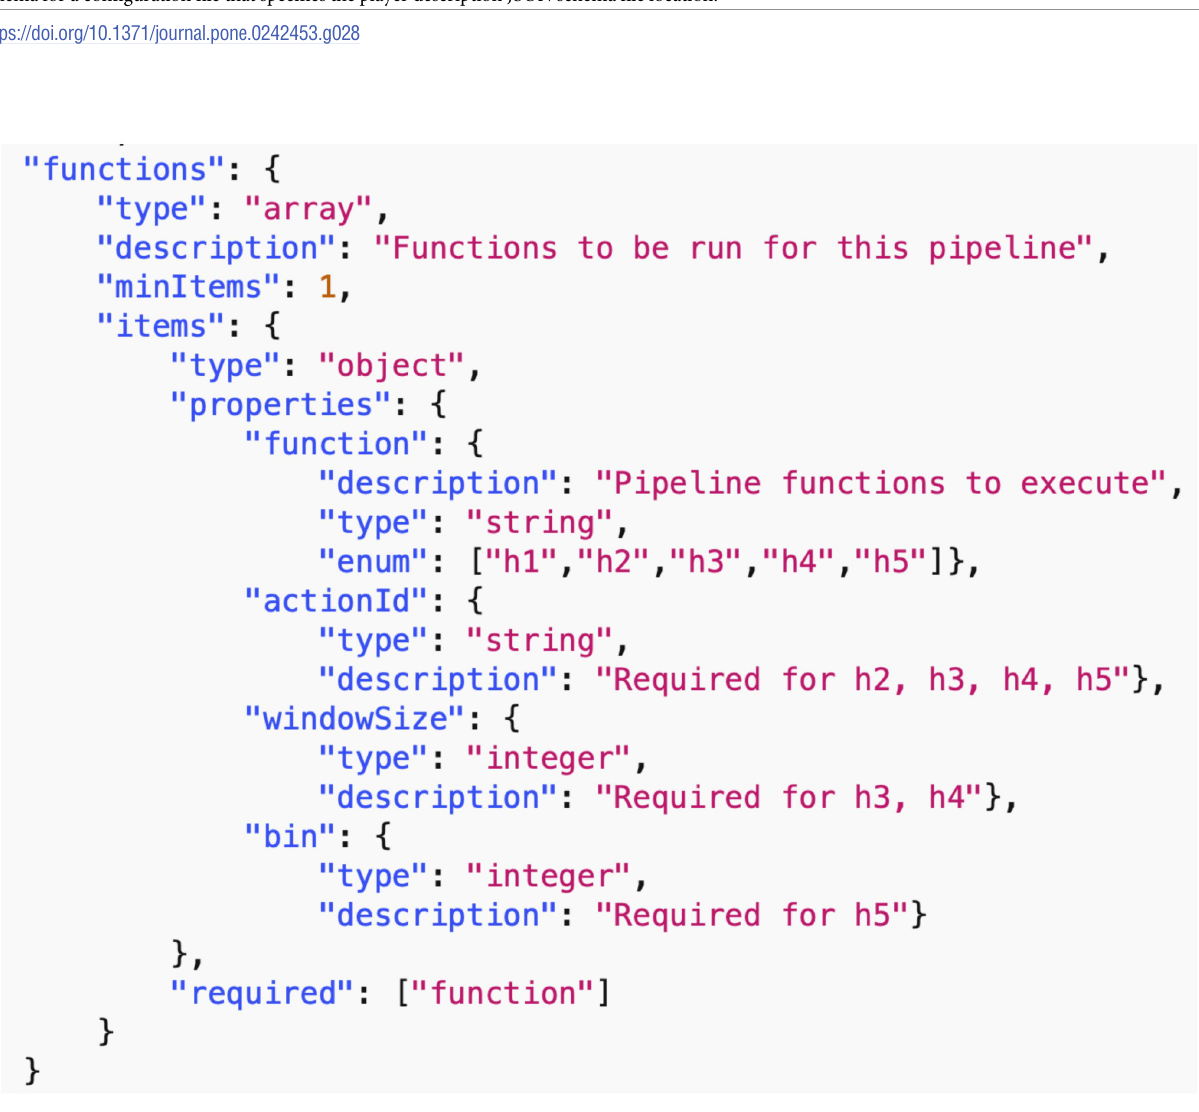
Fig 29. To run a pipeline (called a job), a configuration input file specifies functions and their order of execution. In this configuration file there are five possible functions that can be executed in any order. This Figure shows a portion of the schema for a configuration file that specifies how to compose and execute one or more functions of a simple pipeline. For example, here it defines that a parameter called “actionId” is only necessary for functions h 2 through h 5 .